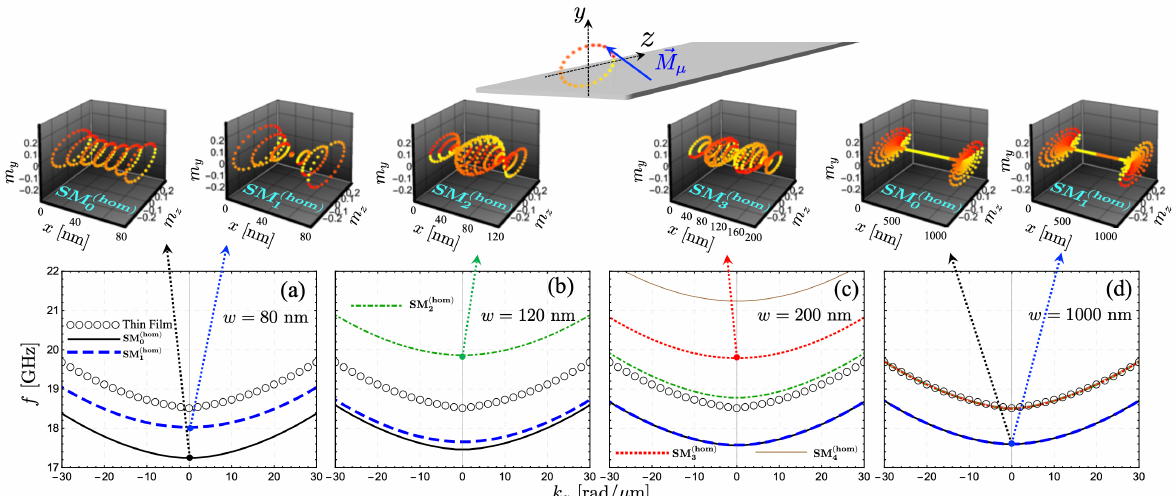
Figure 2. Spin-wave dispersion in a homogeneous ferromagnetic nanostrip. In ( a – d ), different values of the strip width, w , have been considered. The open circles show the SW dispersion of a ferromagnetic thin film, whereas the lines are the spin-wave modes of a magnetic nanostrip. Upper 3D graphics correspond to the spin-wave profiles along the strip’s width evaluated at k z = 0, where the dynamic magnetization components are calculated in arbitrary units. In all cases, SM ( hom ) SM are edge modes, while other modes correspond to magnetic excitations with high SW 1 amplitude around the strip center. In ( d ), the first five low-frequency modes have been